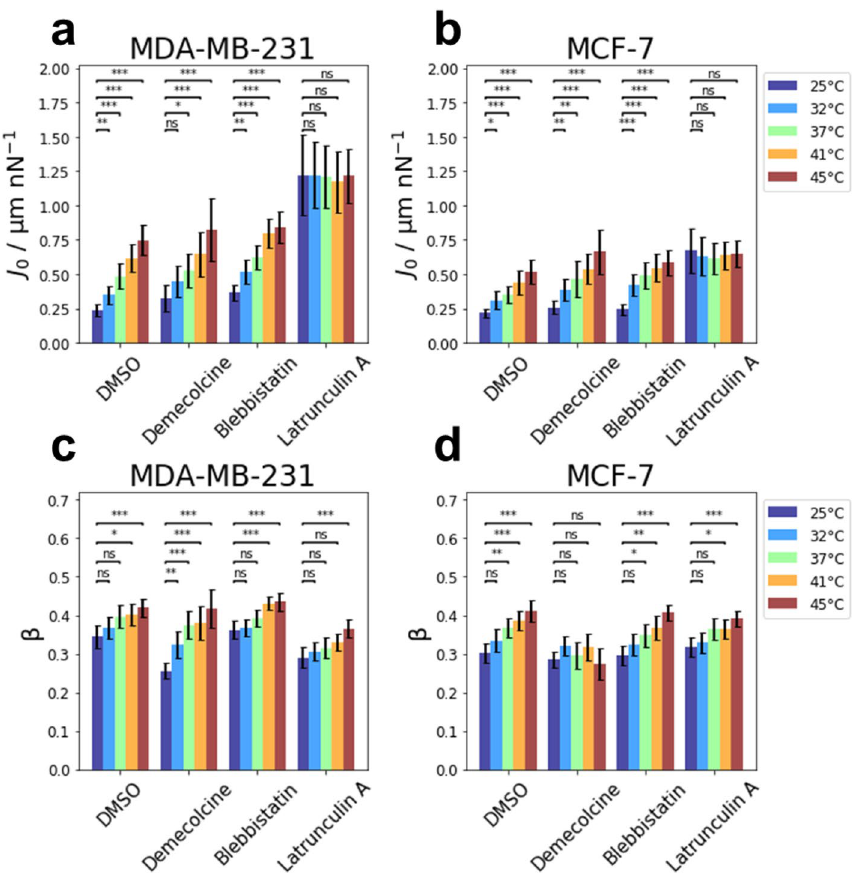
Figure 4. Comparison of the temperature dependence of mechanical properties for MDA-MB-231 and MCF-7 cells after pharmacological intervention. Influence of temperature on the creep compliance of ( a ) MDA-MB-231 cells and of ( b ) MCF-7 cells after treatment with Demecolcine, Blebbistatin and Latrunculin A. Effect of temperature on the cell fluidity β of ( c ) MDA-MB-231 and ( d ) MCF-7 cells after treatment with the afore mentioned